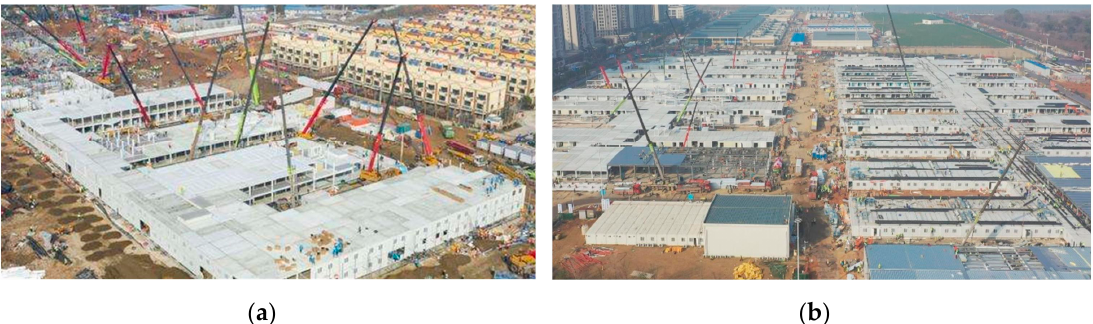
Figure 3. ( a ) Huoshenshan Hospital and ( b ) Leishenshan Hospital under construction (figures are from https: // finance.sina.cn / 2020-02-05 /